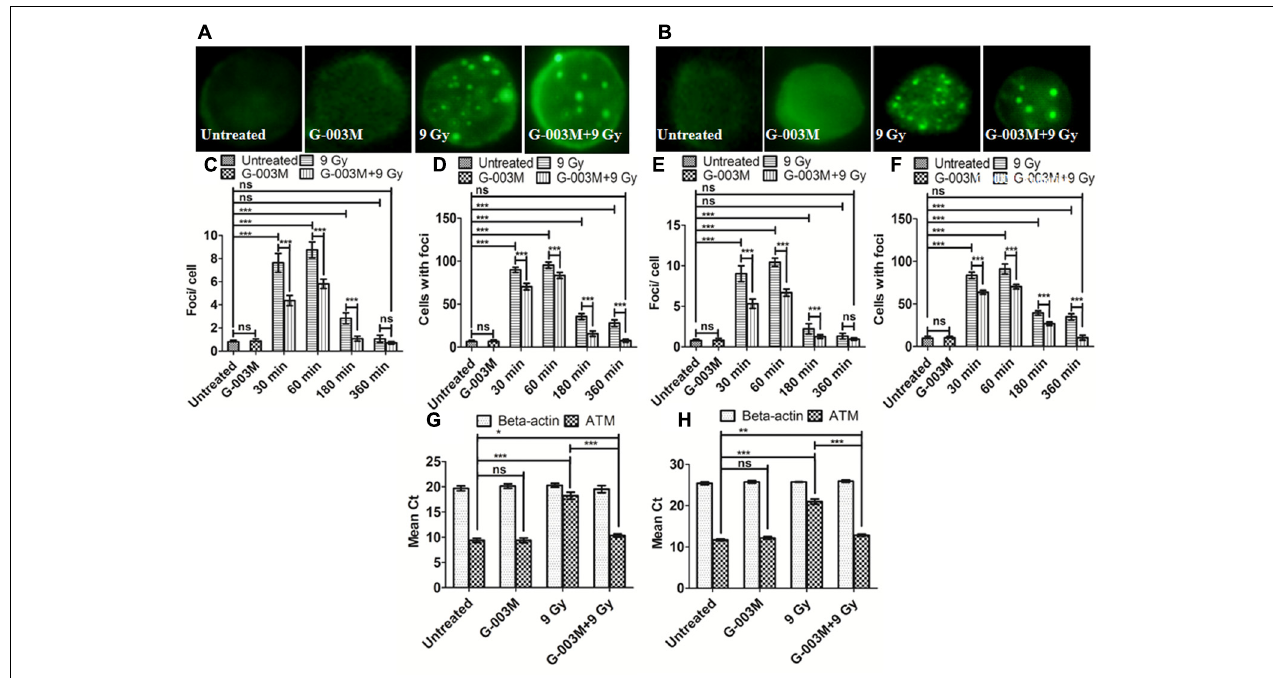
FIGURE 5 | Measurement of ATM kinase in mice blood and bone marrow populations taken at various times after irradiation: (A,B) Representative images of ATM kinase foci in blood and bone marrow respectively. (C) Quantification of ATM kinase foci per cell and (D) ATM kinase foci distribution in blood cells. (E) The graph shows mean ATM kinase foci per cell and (F) the ATM kinase foci distribution in bone marrow cells. (G) The graph represents a quantitative real time PCR bases estimation of β -actin and ATM gene respectively in blood cells processed 1 h after irradiation. (H) The graph represents a quantitative real time PCR bases estimation of β -actin and ATM gene respectively in bone marrow cells processed 1 h after irradiation. n = 6 per